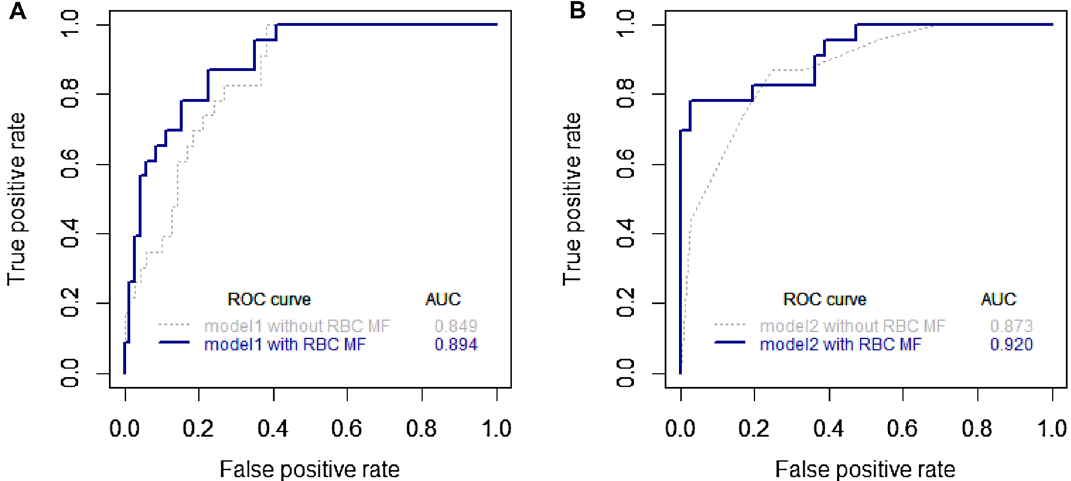
Figure 3. Receiver-operating-characteristic (ROC) curves for CVD by multivariable logistic regression models with or without red blood cell membrane fluctuations (RBC-MFs). ( A ) Model 1 tested in all participants; ( B ) Model 2 tested in patients with diabetes mellitus (DM).